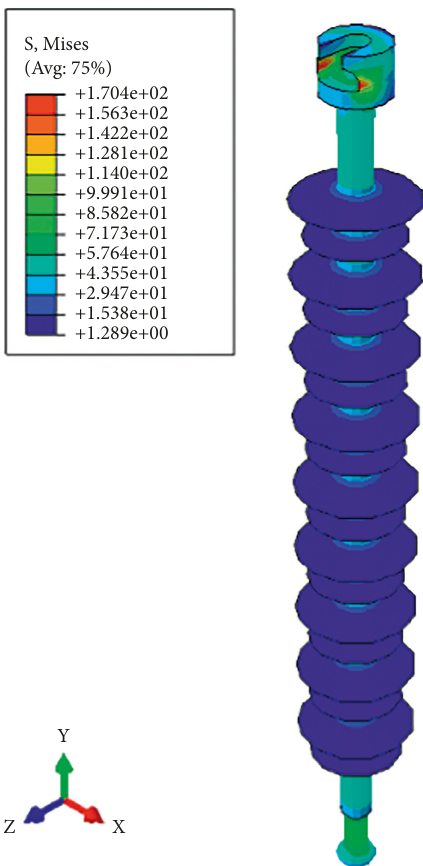
Figure 45: Stress cloud picture of suspension